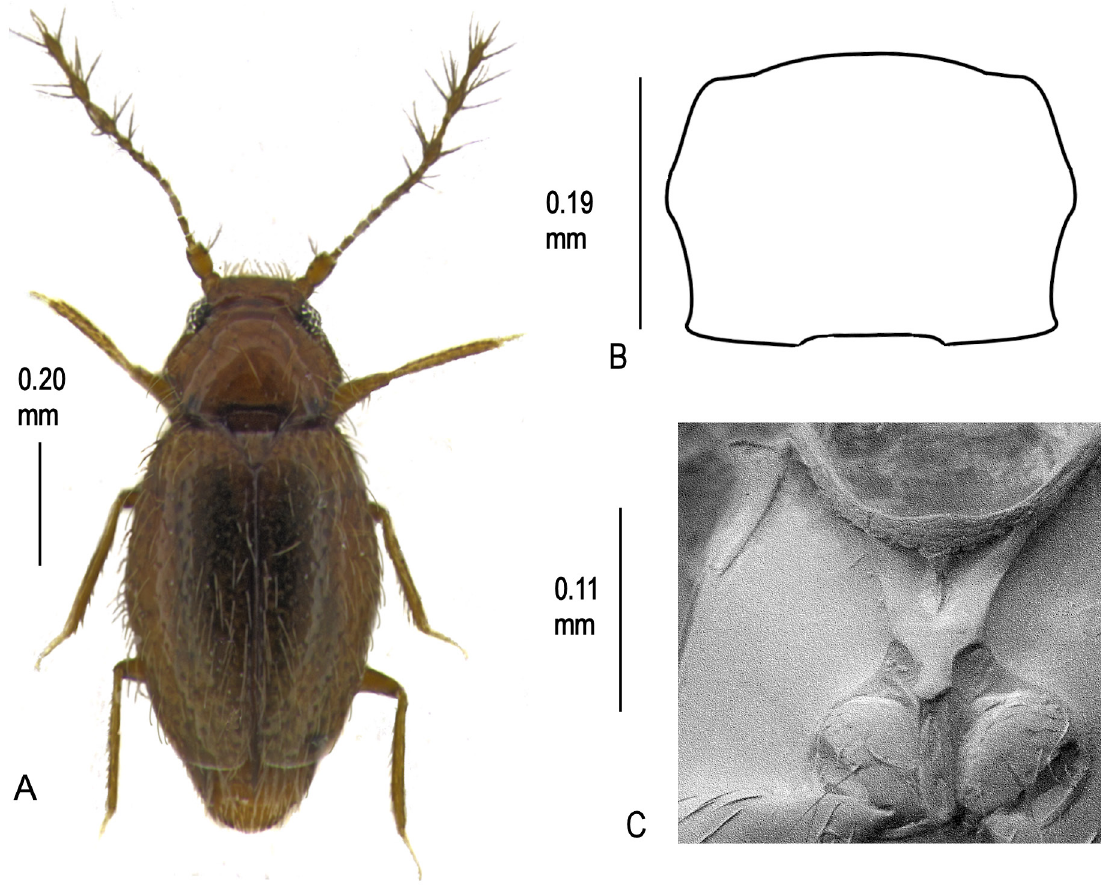
Fig. 94 . Cissidium lisae Darby, 2015. A . Habitus. B . Pronotum, C . Mesoventrite showing median process of collar, mid-keel and keel, ×